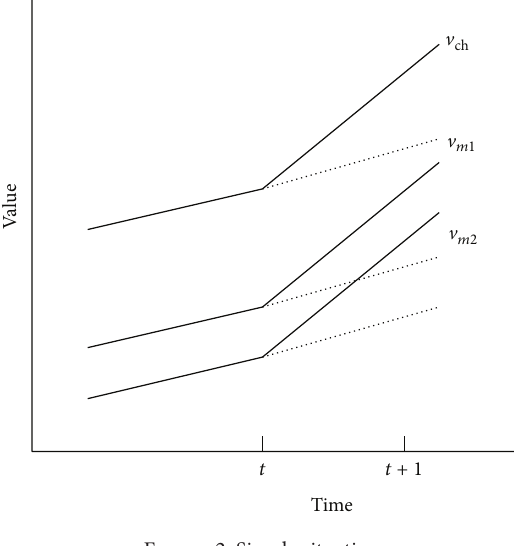
Figure 2: Simple